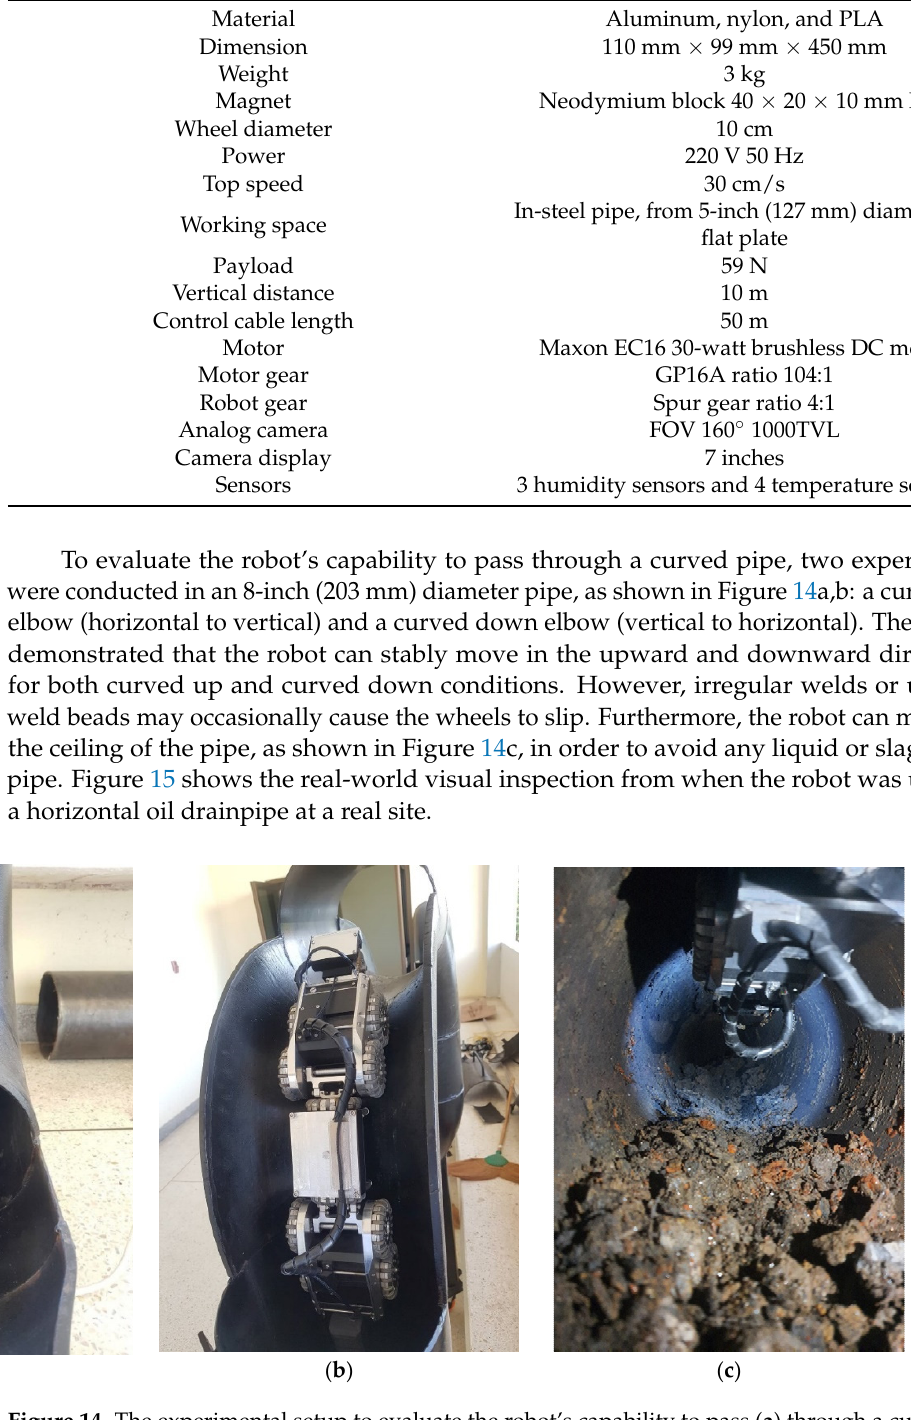
( b ) Figure 15. The internal surface of the pipe captured by the front camera: ( a ) a rusty surface; ( b ) slag ash. 4. Conclusions In this article, a train-like inspection robot was proposed for the visual inspection of the inside of ferromagnetic pipes with a diameter of 5 inches (127 mm) or larger. The robot combined omnidirectional wheels and permanent magnets as the adhesion mechanism between the robot and the pipes. Two perpendicular sets of omnidirectional wheels provided two-directional movements (longitudinal and lateral) and ensured that the robot could travel longitudinally along the path of the pipe. The waterproof robot was designed for operation in waterlogged conditions. The visual control panels were used to control the robot’s movement and to observe the inspection area in real-time through the front and rear cameras. the robot was also equipped with temperature and humidity sensors to provide the real-time monitoring of the pipe’s internal conditions. The robot prototype was tested in several conditions in order to prove that the robot is capable of passing through straight and curved pipes in any direction. The developed robot can also be applied for the external inspection of ferromagnetic structures, such as ferrous storage tanks. Autonomous functionalities, such as surface examination and corrosion detection, are very interesting and will be the focus of our future investigation. Author Contributions: Conceptualization, K.T.-O.; methodology, T.M. and A.B.; writing—original draft preparation, T.S. and K.K.; supervision, K.K.; investigation, K.T.-O., K.K., T.M., T.S. and A.B. All authors have read and agreed to the published version of the manuscript.